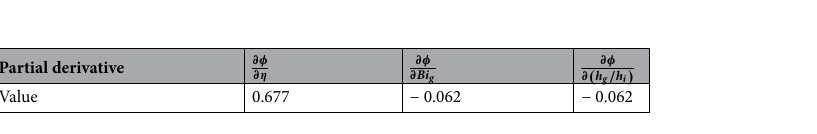
Table 2. Specific partial derivatives with respect to each dimensionless